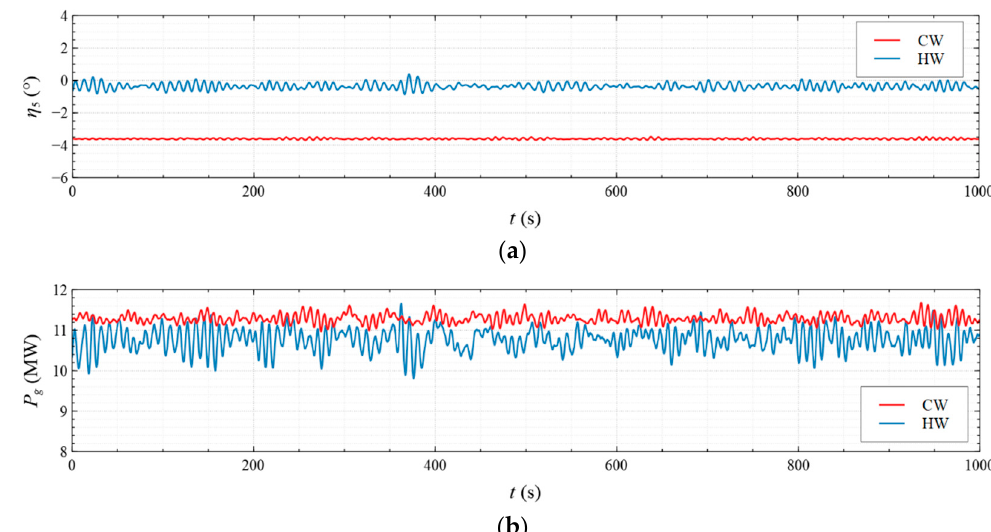
Figure 13. Time histories of ( a ) pitch motion and ( b ) power output under θ w = 0 ◦ and θ c = 0 ◦